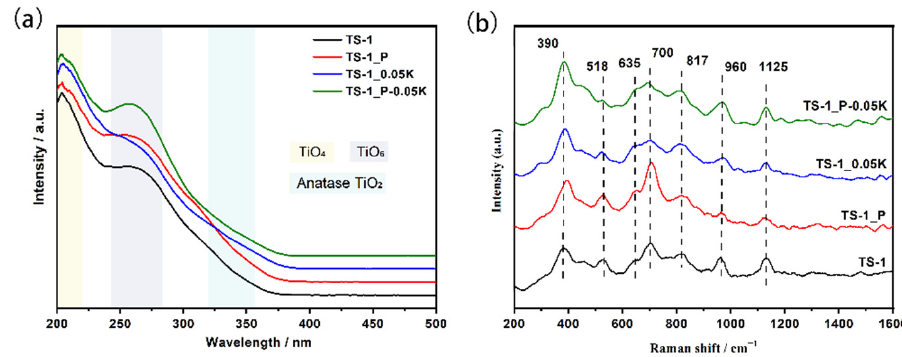
Figure 4. UV-vis spectra ( a ) and UV-Raman spectra excited at 325 nm ( b ) of various TS-1 samples. Ultraviolet resonance Raman spectroscopy with an excitation line at 325 nm was used to further study the change of Ti species caused by the post-modification treatment (Figure 4b). According to the related literature [56,57], the peaks at 390 cm − 1 and 817 cm − 1 were attributed to the stretching vibration of the siloxane bond (Si-O-Si) of pure silicon S-1 zeolite. The absorption peaks at 960 cm − 1 and 1125 cm − 1 were related to the framework TiO 4 species. The weak absorption peaks located at 518 cm − 1 and 635 cm − 1 were